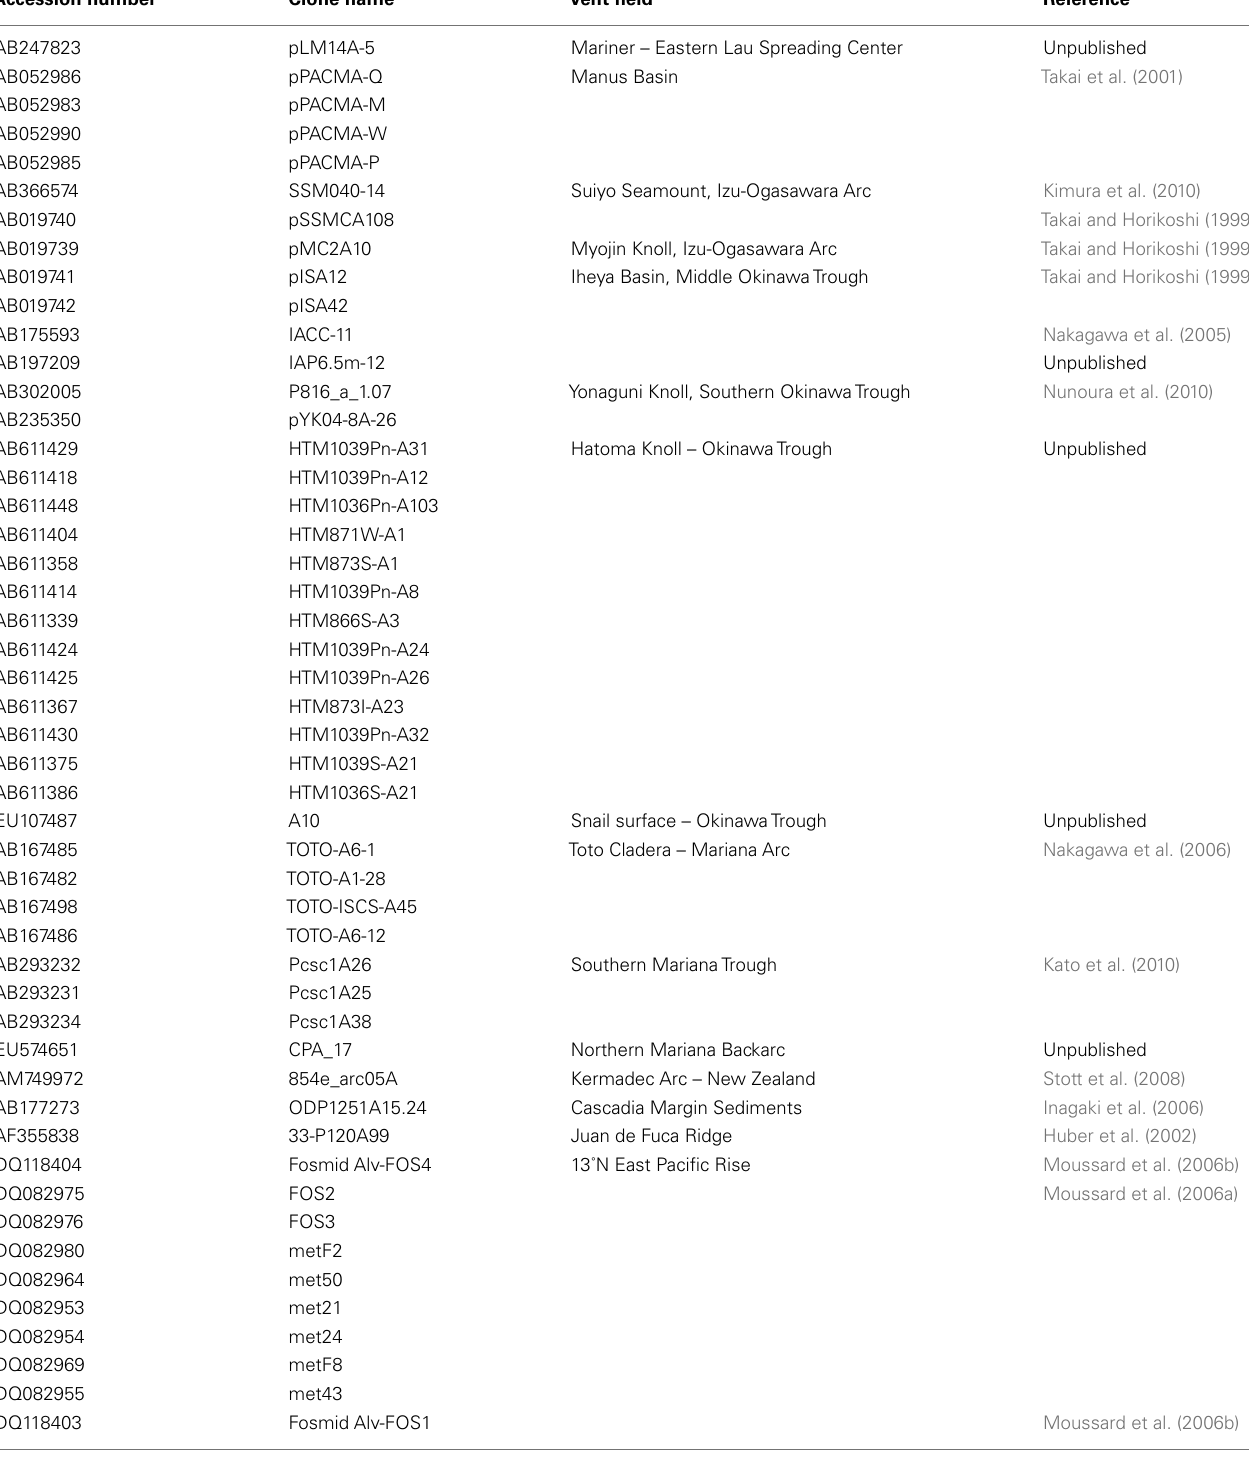
TableA1 | Summary of 16S rRNA gene sequences previously detected in marine hydrothermal